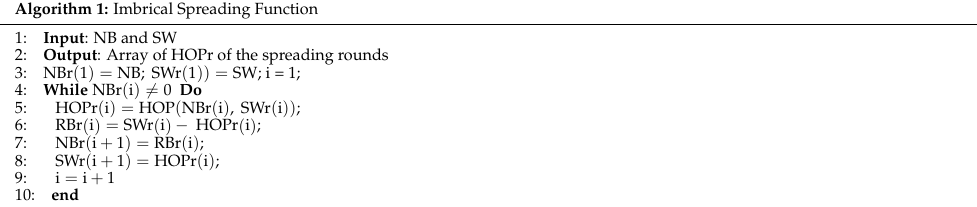
Algorithm 1: Imbrical Spreading Function